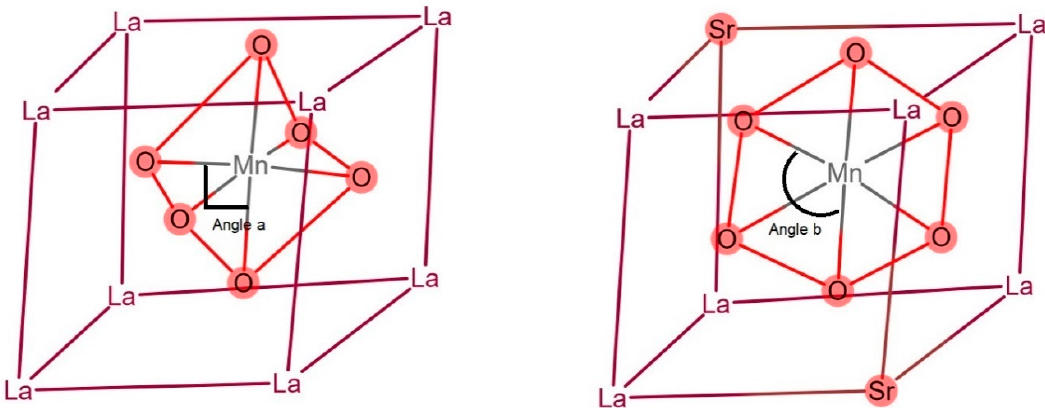
Figure 11. Sr substitution increased the bond angle of Mn 3+ –O 2 − –Mn 4+ : the bonding angle of Mn 3+ – O 2 − –Mn 4+ in LaMnO 3 was 90° ( left ). However, Sr substitution distorted the structure; therefore, the angle was >90° ( right ).